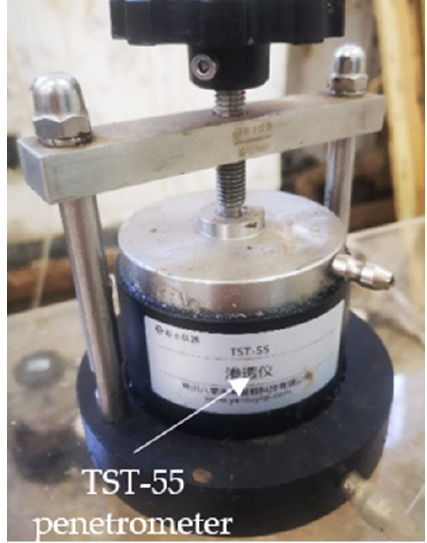
Figure 3. TST-55 penetrometer.